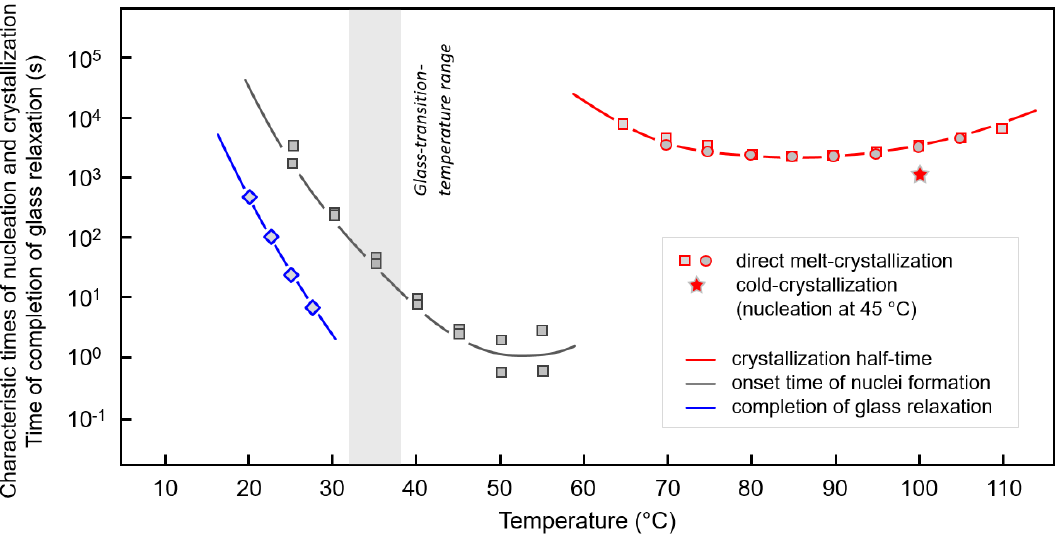
Figure 6. Time of completion of enthalpy relaxation (blue), onset time of nuclei formation (gray), and crystallization halftime of PBI (red) as a function of temperature. Crystallization halftimes were determined on direct melt-crystallization (see also Figure 1a, squares and circles) and after prior nuclei formation at 45 °C for different times (star symbol). The nuclei-transfer heating rate, that is, the rate of heating the nuclei from 45 °C to the growth-temperature, was 50 K/min.